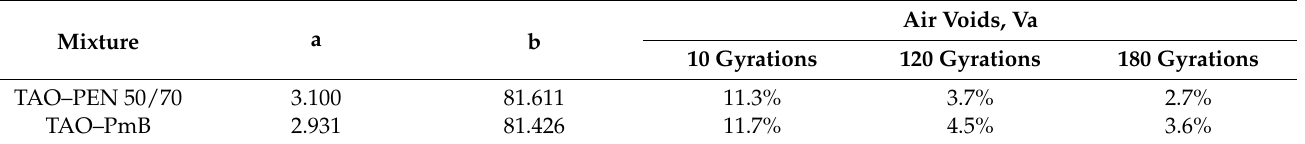
Figure 4. Compaction curves of TAO–PEN 50/70 and TAO–PmB and their models. Table 4. Parameters of compaction curves models and air voids of TAO–PEN 50/70 and TAO– PmB.